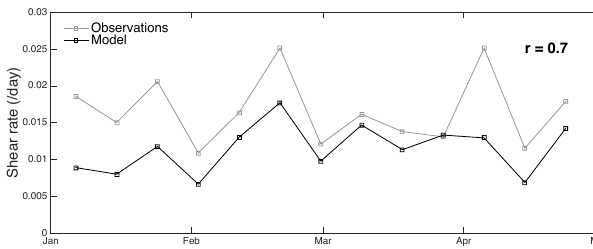
Figure 10. Mean value of the shear rate distributions corresponding to 13 periods of 9days between January and May 2008. The defor- mation rates are computed at a spatial scale of 20km for matching times and locations between the observation and the model follow- ing the same procedure as in Bouillon and Rampal